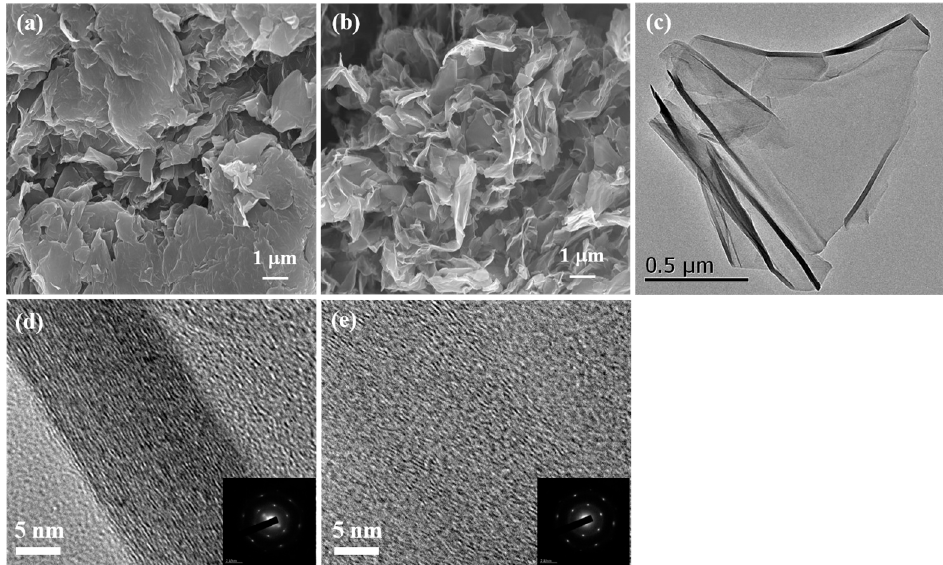
Figure 3. SEM images of ( a ) GO and ( b ) IrGO ‐ Tpy; TEM images of IrGO ‐ Tpy ( c ) at low ‐ magnification and ( d ) at high ‐ magnification on the edges with selected area electron diffraction (SAED) pattern. ( e ) High ‐ magnification TEM images of the basal area with selected area electron diffraction (SAED)